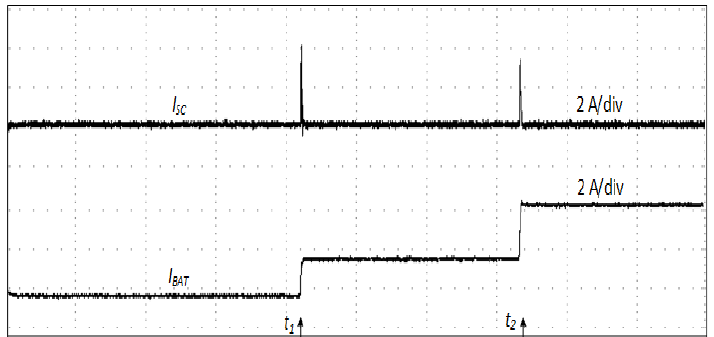
Figure 24. Voltages of the supercapacitor, battery, PV, and DC bus captured by the oscilloscope.